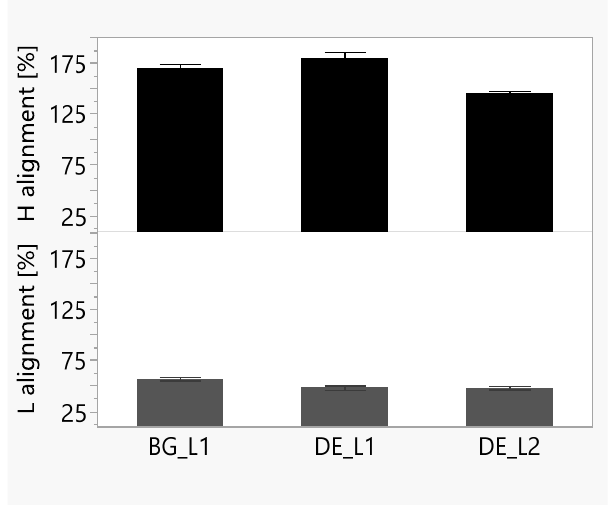
Figure 8. Mean alignment values (in%) of the L target ( lower panel ) and H target ( upper panel ) relative to the syllable onset for the three data sets. Error bars represent standard errors. For the alignment of the H target we also found that the peak is aligned earlier in DE_L2 (145%, i.e., slightly before the middle of the post-accented syllable) than in the L1 data sets (170% vs. 179% for BG_L1 and DE_L1, respectively, i.e., within the second half of the post-accented syllable). Given that it has been reported previously that speech tempo influences the alignment of tonal targets (e.g., Silverman and Pierrehumbert 1990),